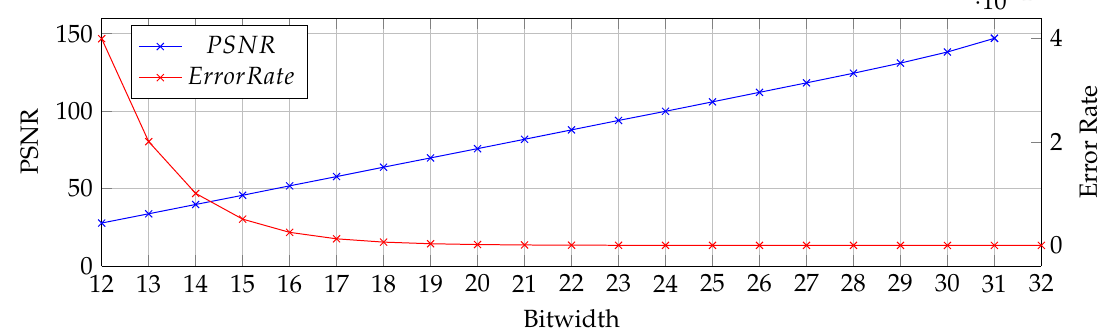
Figure 12. Bitwidth vs. average PSNR and error rate of 1024-point